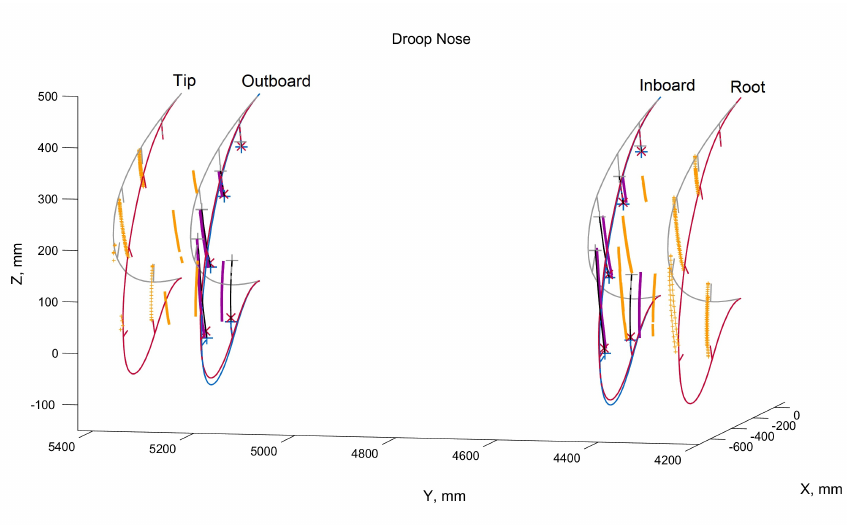
Figure 17. Postprocessed ARAMIS data in the finite element analysis (FEA) coordinate system showing different spanwise measurement